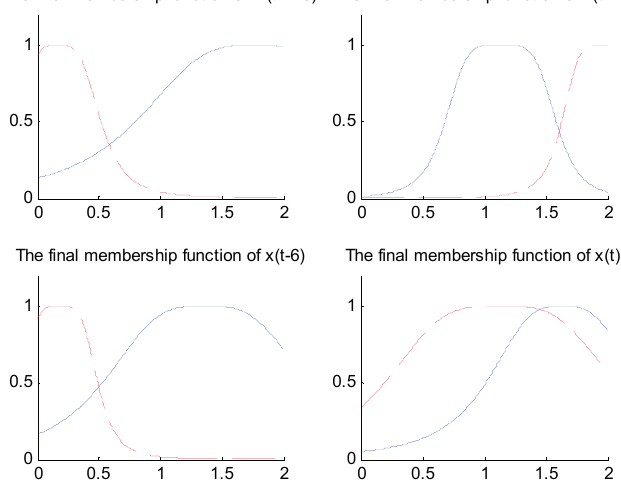
Figure 4. Final membership functions